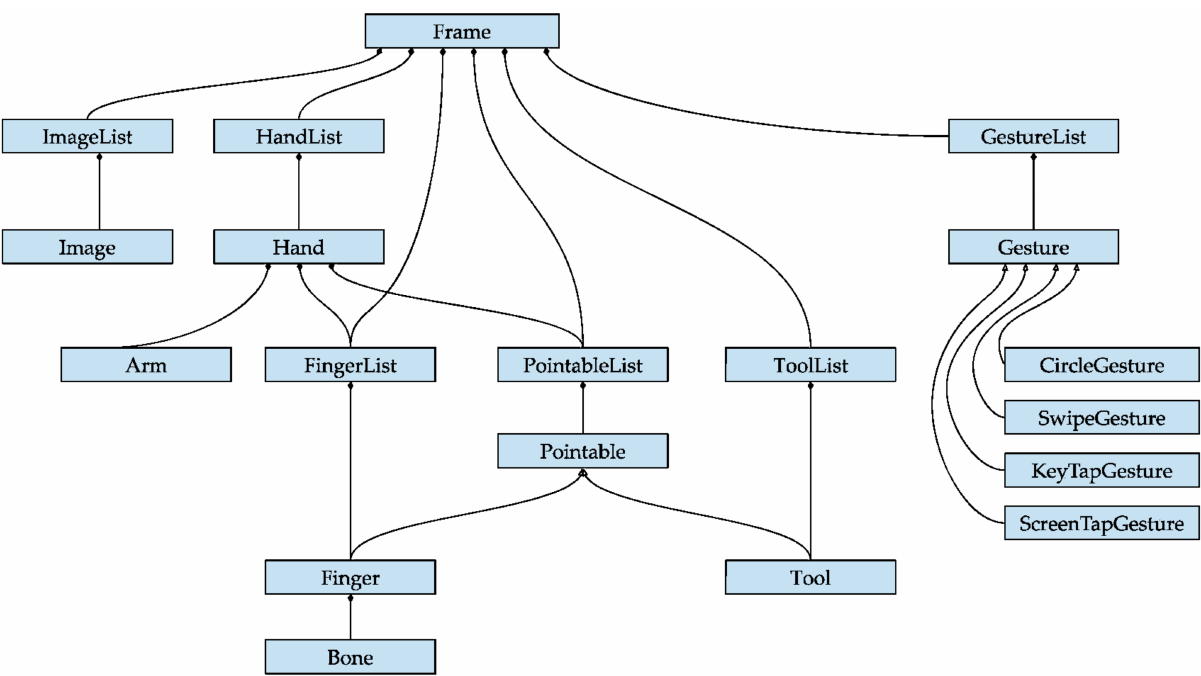
Figure 1. Frame Object of Leap Motion. Source available online: https://www.researchgate.net/ figure/Frame-Object-of-Leap-Motion-Source_fig5_342433909 (accessed on 29 December 2022).